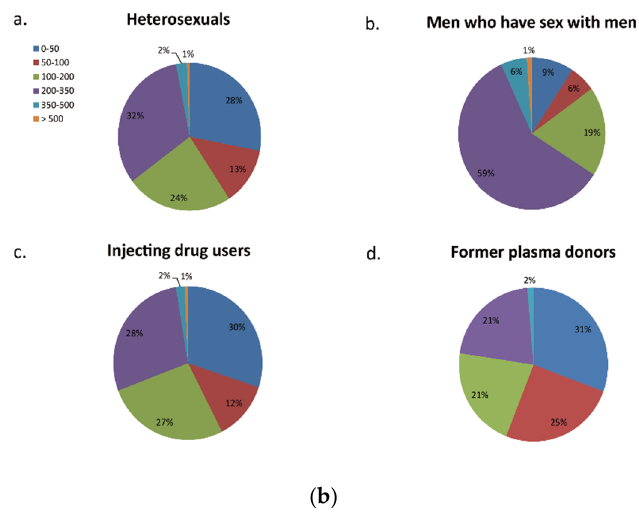
Figure 1. ( a ) CD4 T cell variation in populations stratified by transmission routes since initiation of antiretroviral treatment (ART); (The grey dot represents the median value, whereas the rectangular box represents the interquartile range of the distribution. The maximum and minimum values are marked with blue bars in each box plot). ( b ) Composition of CD4 counts in populations stratified by transmission routes, i.e., a. heterosexuals; b. men who have sex with men; c. injecting drug users; d. former plasma donors, at ART initiation. Table 1. Demographic characteristics of Participants.